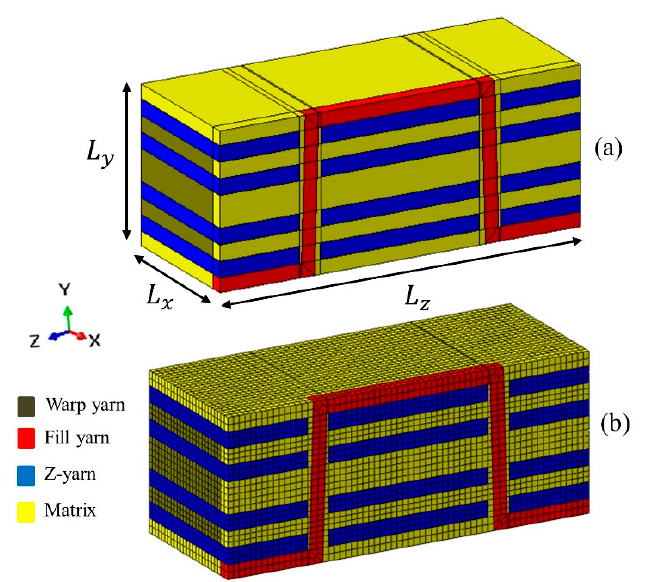
Figure 7. Representative volume element (RVE) of 3D-FRC, ( a ) geometry of 3D-FRC along with parameters, ( b ) meshed geometry of 3D RVE.